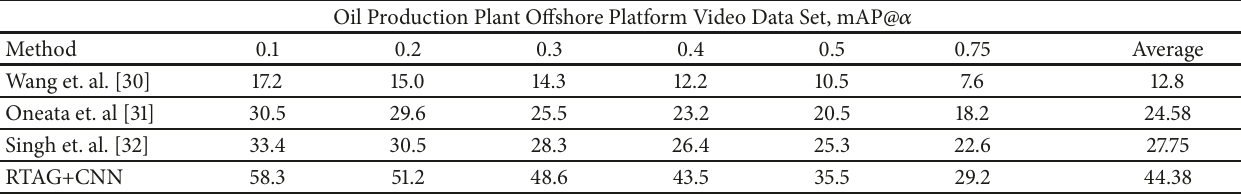
Figure 8: One person recognition and location. Table 2: Action Detection Results for the Oil Production Plant Offshore Platform Video Data